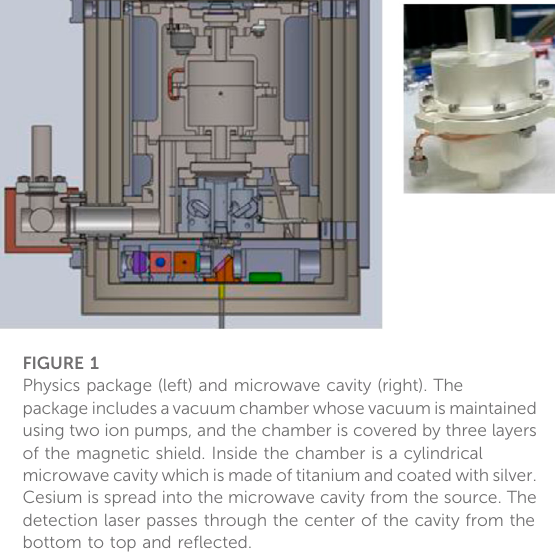
Figure 1. This cavity, made of titanium with a silver-coated inner surface, shown in Figure 1 (right), has two functions: one acts as a microwave resonator for the interrogation of microwaves with atoms, and the other is for diffuse laser cooling [10]. The cavity is